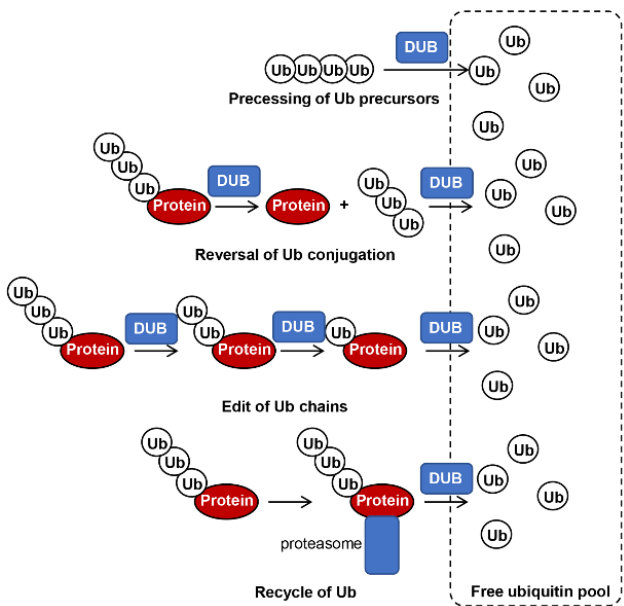
Figure 1. General roles of DUBs in fungi. DUBs play different roles in processing of ubiquitin pre- cursors, reversal of ubiquitin conjugation, editing of ubiquitin chains, and recycling of ubiquitin